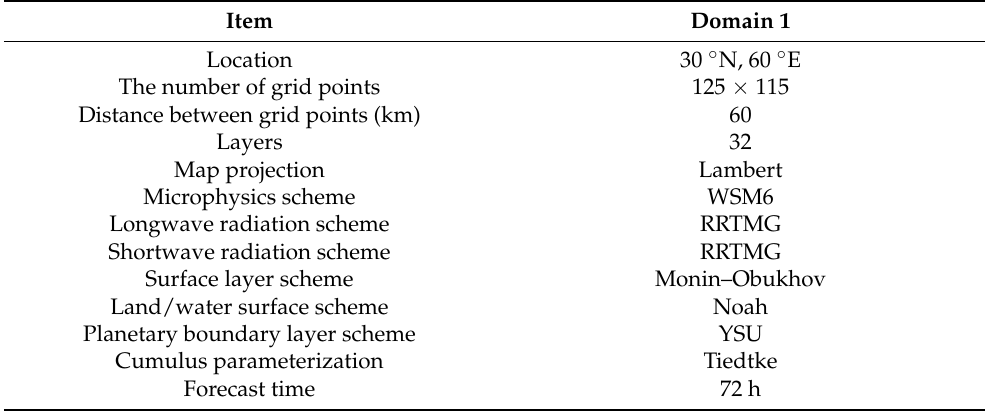
Table 1. Selection of scheme and parameters of the WRF